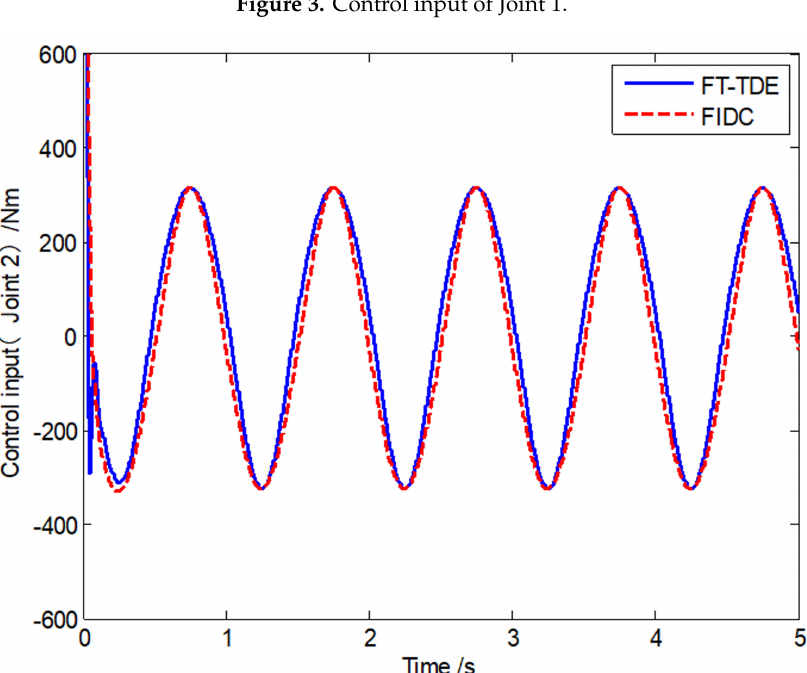
Figure 4. Control input of Joint